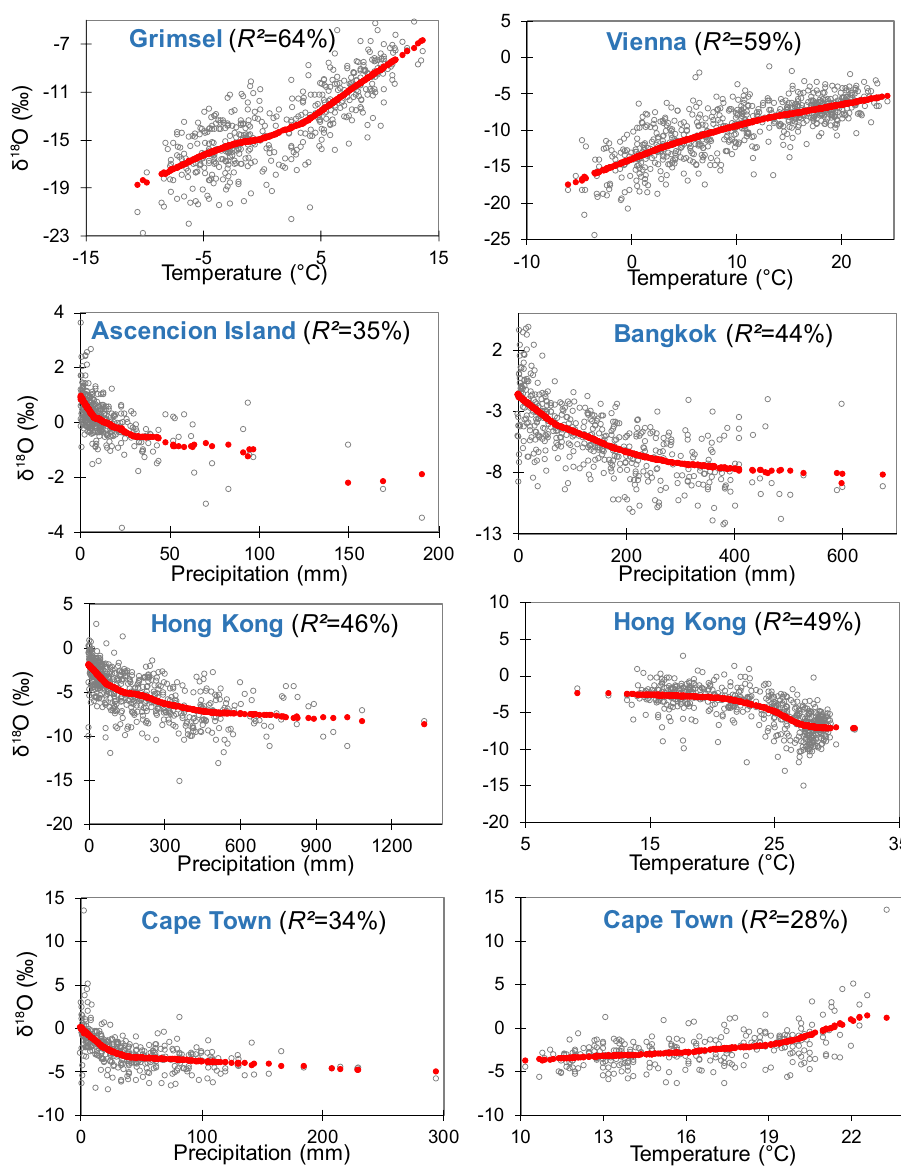
Figure 2. Polynomial trends (red) fitted by nonparametric regression models for δ 18 O versus T and P (grey dots) for selected long-term GNIP stations.